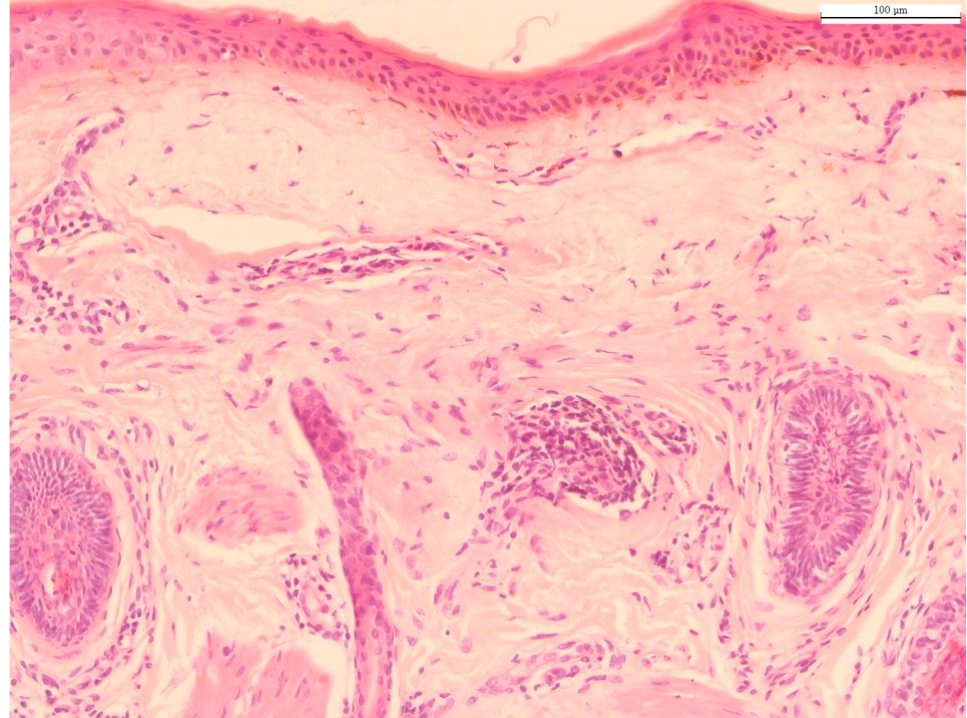
Figure 1. Histology of photoaged skin. The predominant histological finding of photodamaged skin is solar elastosis, i.e., basophilic degeneration of elastotic fibers in the dermis. Solar elastosis is separated from the epidermis by a narrow band of normal-appearing collagen (grenz zone), with collagen fibers arranged horizontally (hematoxylin and eosin staining; original magnification 100 × ). Source: HJ Lee and M Kim.